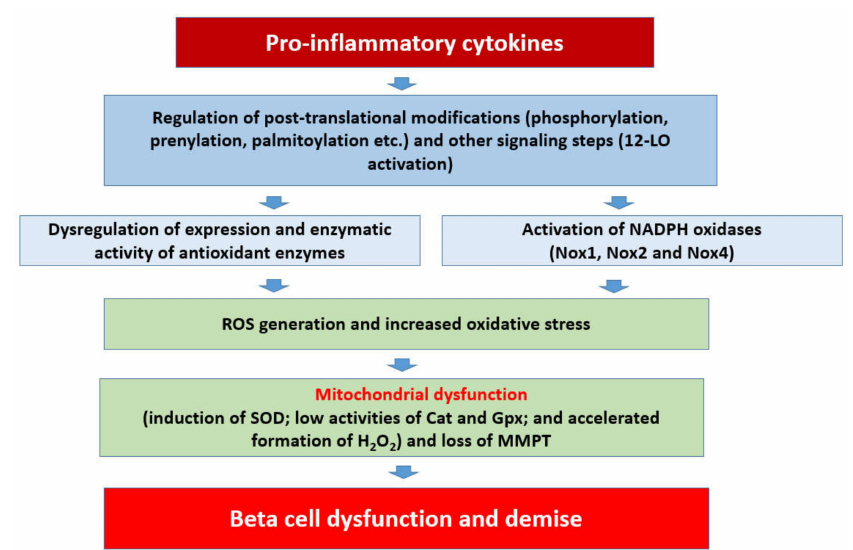
Figure 2. Potential signaling mechanisms involved in cytokine-induced Nox-mediated dysregulation of the islet